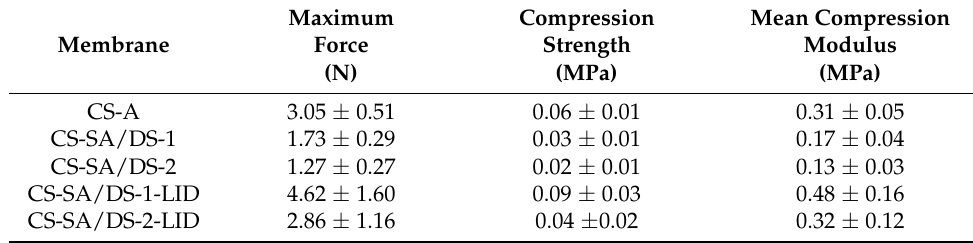
Maximum Force (N)